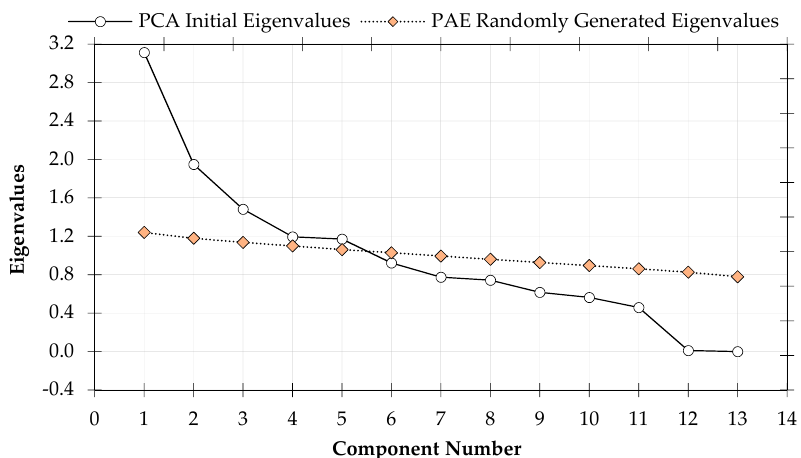
Figure 5. Determination of Principal Components (PCs) to be extracted using eigenvalues from Principal Component Analysis (PCA) and randomly generated eigenvalues from Parallel Analysis Engine (PAE). Source: PCA results from IBM SPSS Statistics [53] and Parallel Analysis Engine [68]. Notes: randomly generated eigenvalues were established using PEA, whereas PCA eigenvalues were established using dataset from Umgeni Water Board.